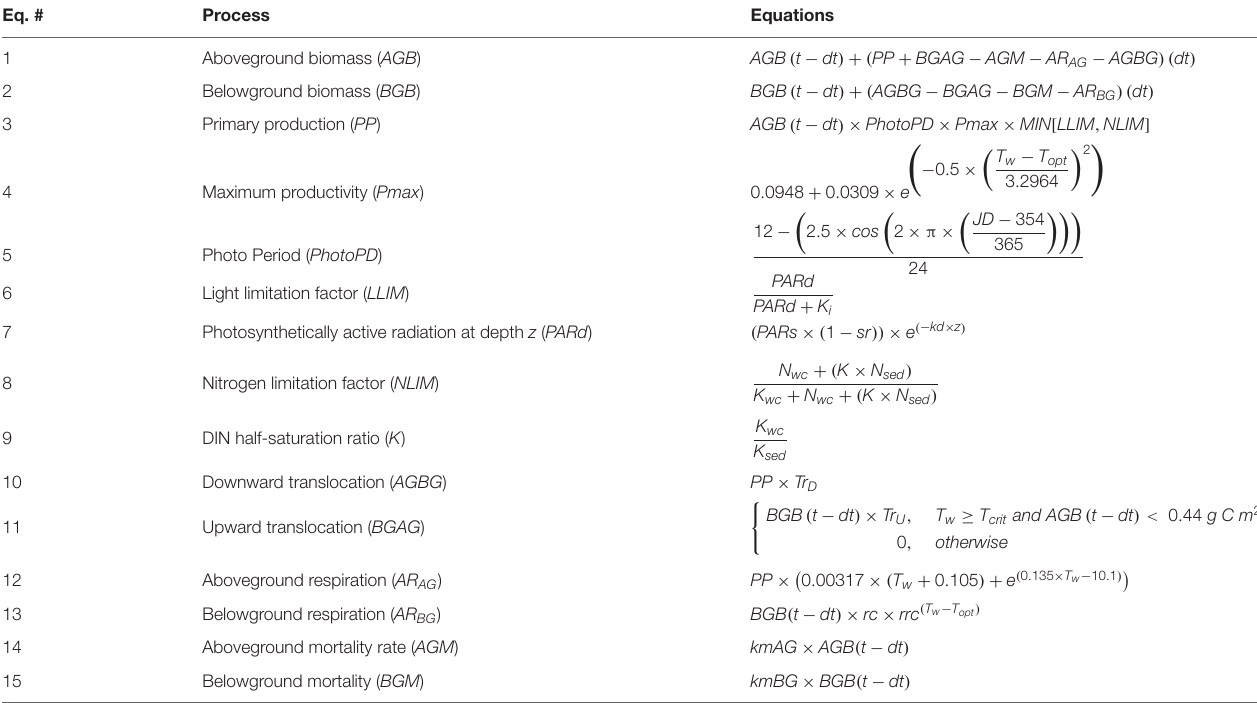
TABLE 1 | Equations defining processes within the biomass production model, where t is the model day, dt is the daily timestep, Tw is water temperature ( ◦ C). Eq. # Process